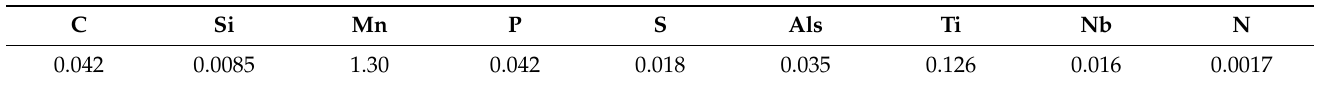
Table 1. Chemical composition of the Ti-Nb microalloyed hot-rolled enamel steel (wt.%). C Si